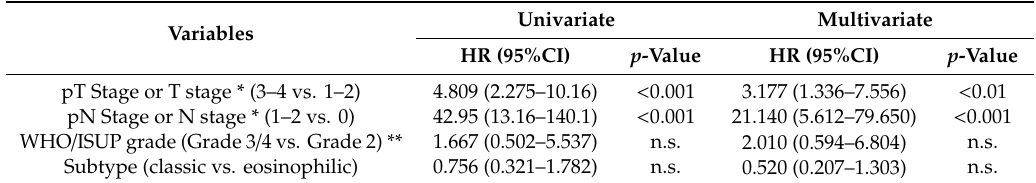
Table 3. Univariate and Multivariate Cox regression analysis on overall survival of 225 chRCC patients combined from Swiss, TCGA-KICH and Japanese cohorts.